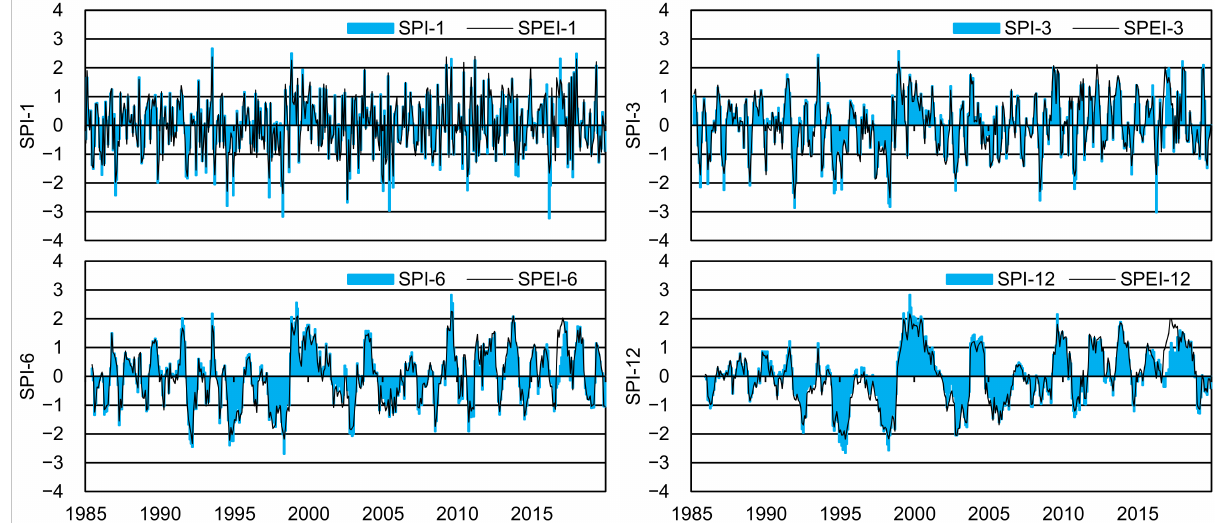
Figure 7. Comparison of the SPI and SPEI at 1-, 3-, 6-, and 12-month timescales at the Butterworth station from 1985 to